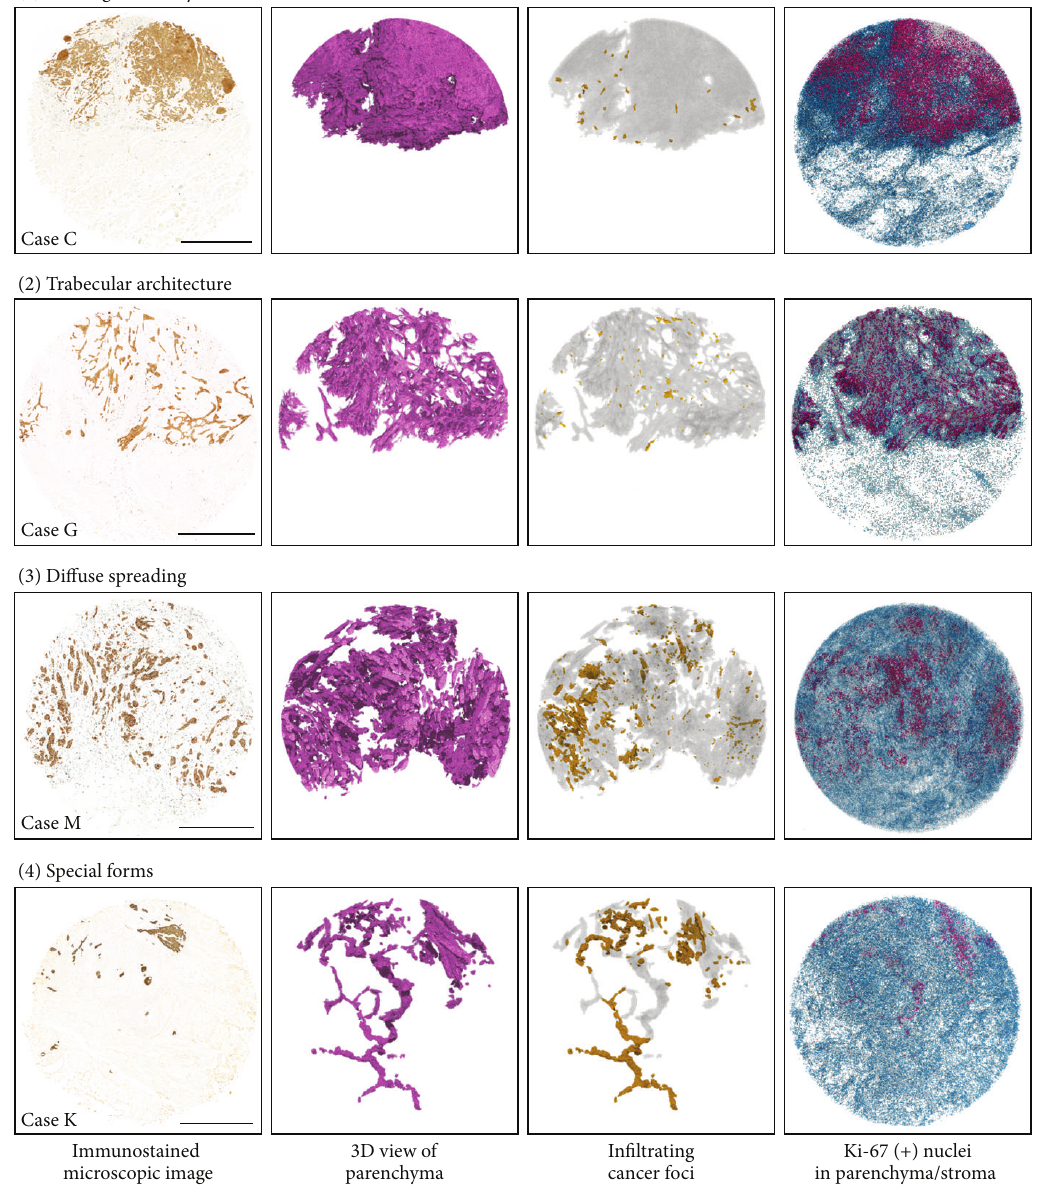
Figure 4: Four types of tumor architecture and mitotic activity at the OTSCC invasion front. Images are from left to right: the immunostained microscopic (2D) image; 3D view of the segmented tumor parenchyma; 3D view of infiltrating cancer foci (yellow) detached in all dimensions from the bulk tumor parenchyma (gray); and Ki67-positive nuclei in the tumor parenchyma (red) and stroma (blue). Additional 3D data obtained from the remaining 10 OTSCC cases can be found in Supplementary Material Plates S2 and S3. Bar =